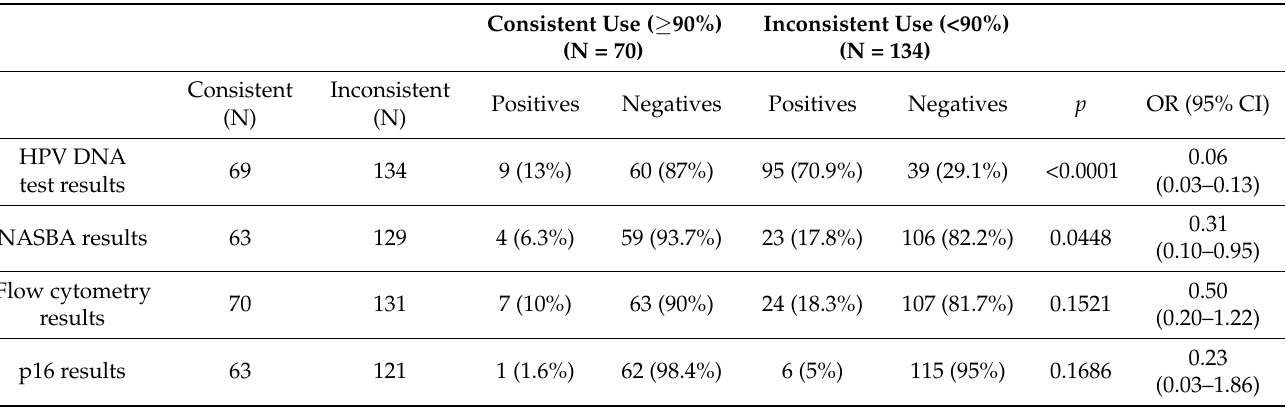
Table 5. Laboratory outcomes for the two groups and statistical comparison after 24 months of follow up.